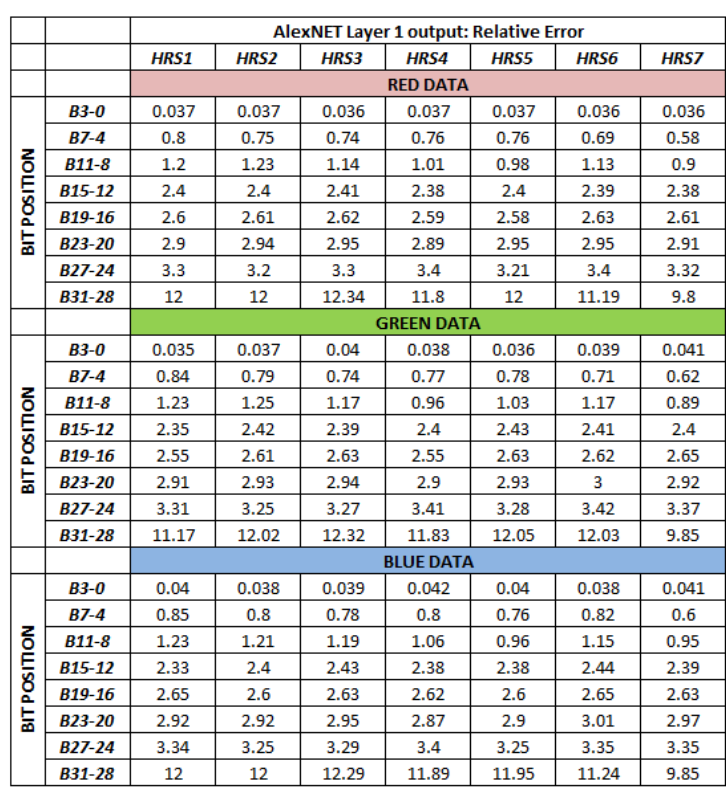
Figure 15. Definition of the relative error (RE) in computed matrix sum of products for the software and hardware flow convolution pipeline. The software pipeline refers to the algorithm trained weights while the hardware pipeline refers to the binary data encoded from the measured RRAM resistance distributions.